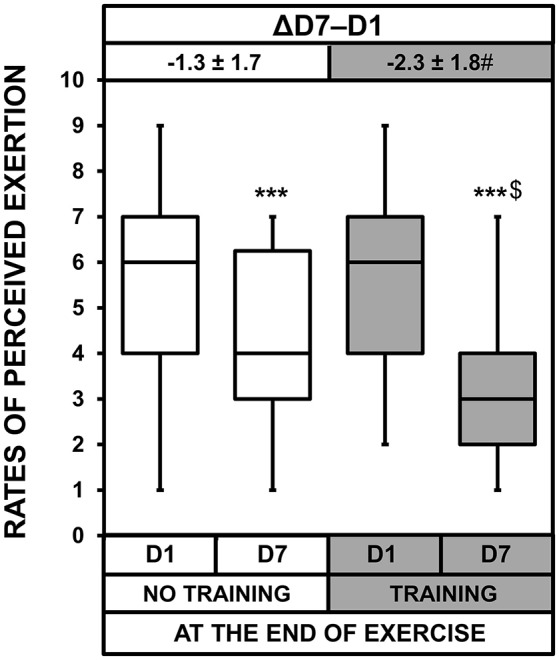
Box-and-whisker plots for the rates of perceived exertion of the No Training and Training groups before (D1) and after (D7) heat acclimatization at the end of exercise. The box encompasses the 25–75% quartiles, and the median is represented by the horizontal line within the box. The whiskers extend to the highest and lowest values. Values shown above the boxes, at the top of the plot correspond to the differences (mean ± SD) between D7 and D1. Significantly different from D1, ***p < 0.001; significantly different from NT group, $p < 0.05; ΔD7-D1 significantly different from NT group, #p < 0.05.